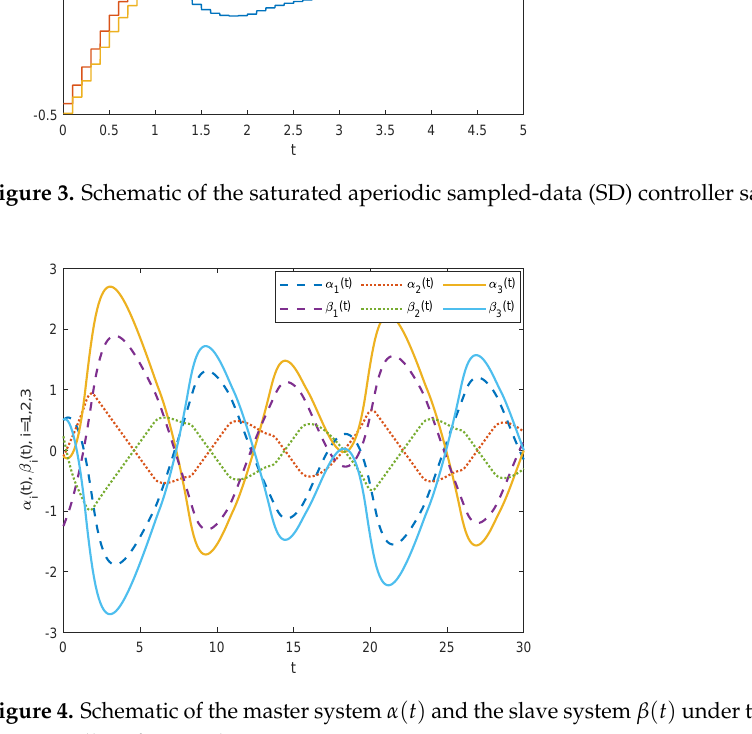
Figure 4. Schematic of the master system α ( t ) and the slave system β ( t ) under the saturated aperiodic SD controller of Example